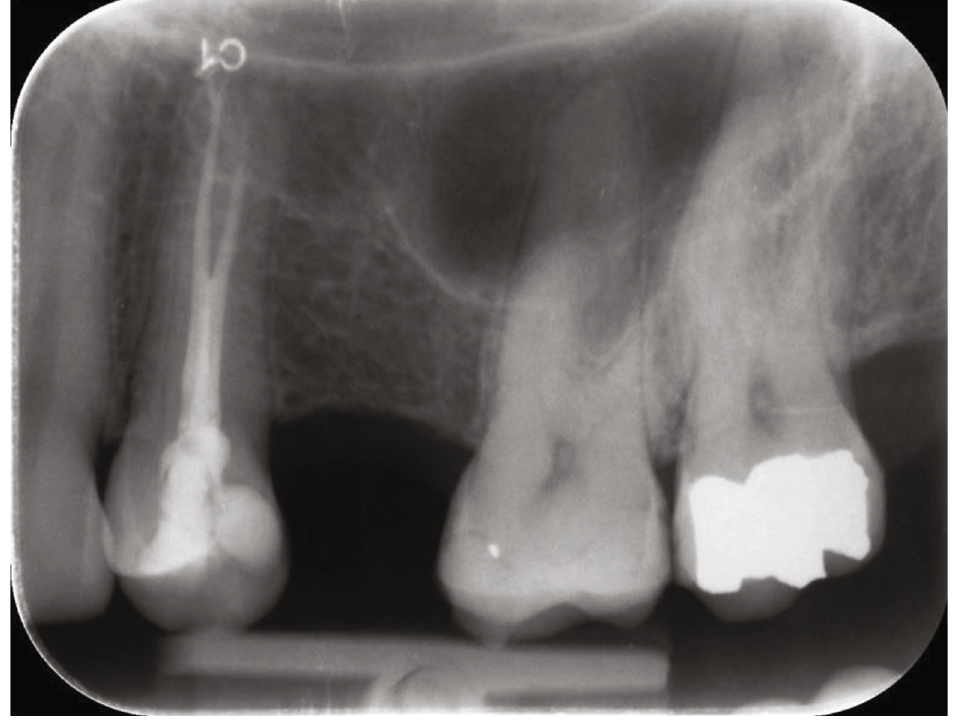
Figure 2: Preoperatory endoral